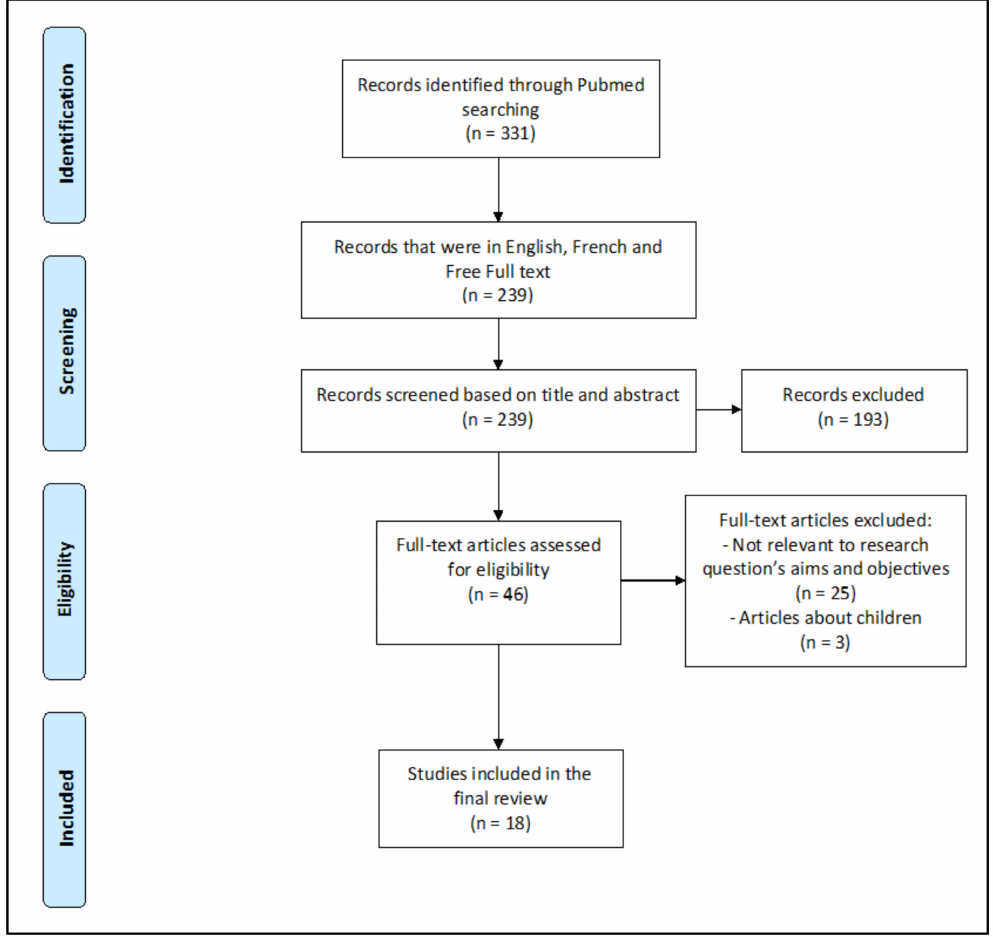
Figure 1. PRISMA guideline flowchart detailing article selection